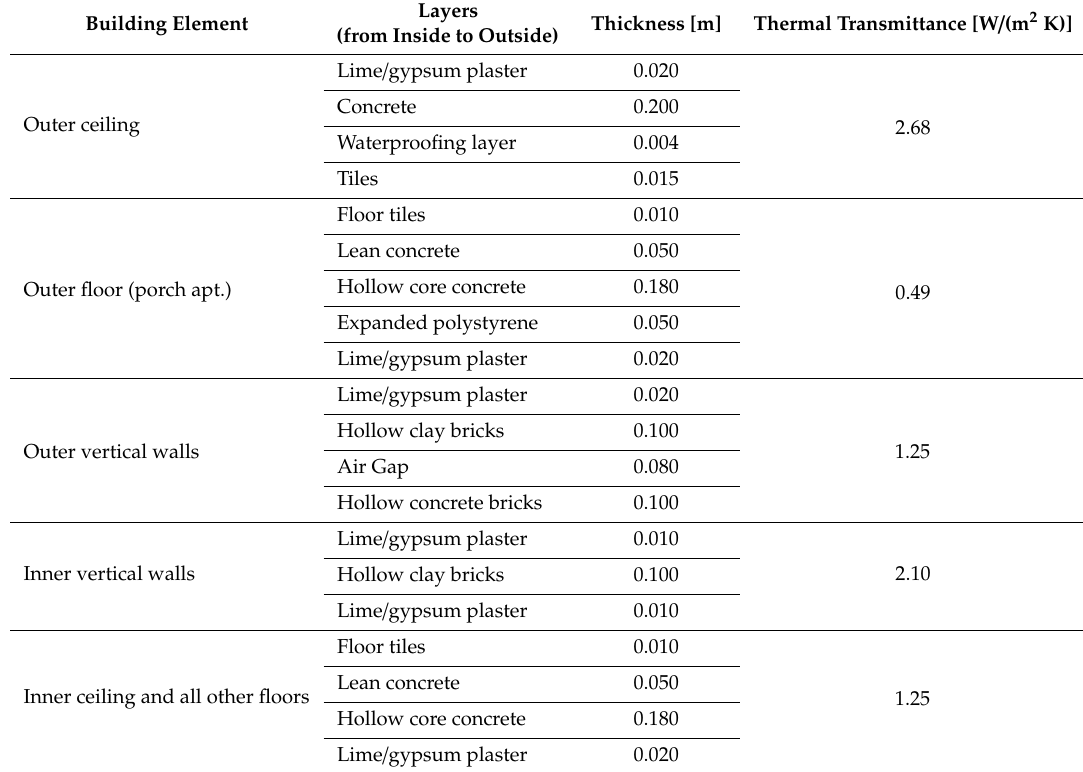
Table 1. Main constructive characteristics of the investigated